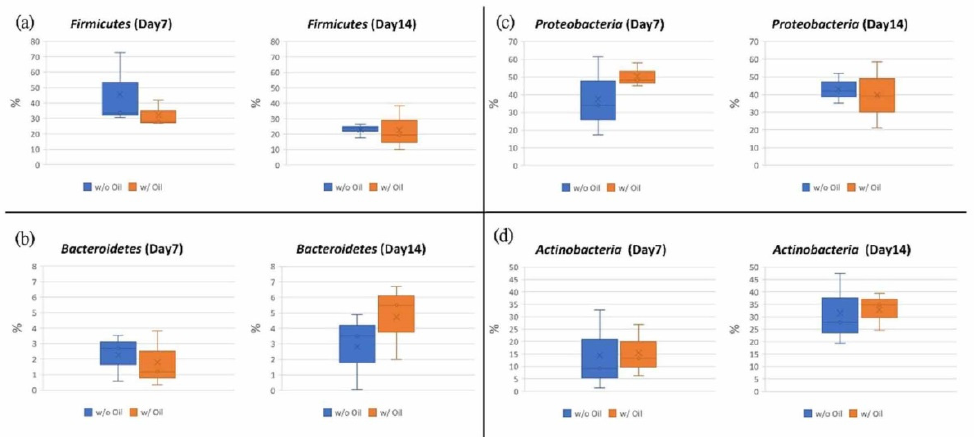
Figure 6. Tested teeth were subjected to ligature-induced periodontitis. Data from samples treated with and without SM oil were compared. Sub-figures show box plot analysis in the phylum of ( a ) Firmicutes , ( b ) Bacteroidetes , ( c ) Proteobacteria and ( d ) Actinobacteria .